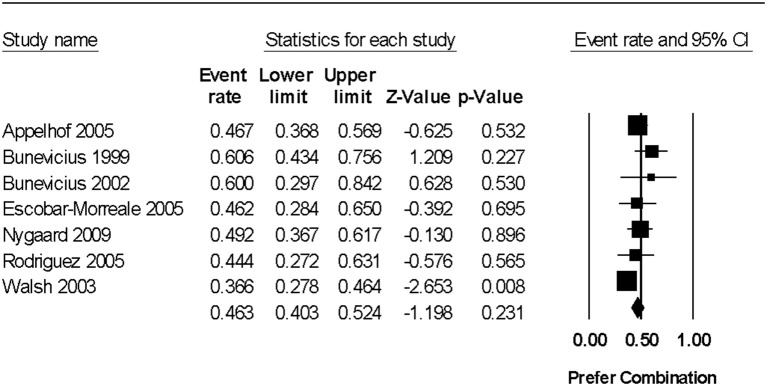
Forest plot from a random effects meta-analysis examining prevalence of preference of combination levo-triodothyronine (L-T3) and levothyroxine (L-T4) therapy over L-T4 alone. 95% CI, 95% confidence interval. For the studies reporting the number of individuals who had no preference (and thus were assumed to favor standard care), the rates were as follows: Bunevicius et al. (15)−33.3% (11/33), Bunevicius et al. (16)−20.0% (2/10), Nygaard et al. (18)−35.6% (21/59), Rodriguez et al. (19)−29.6% (8/27), and Walsh et al. (20)−17.8% (18/101). It is not known if the individuals with no preference were indifferent or indecisive (i.e., unable to make a decision).